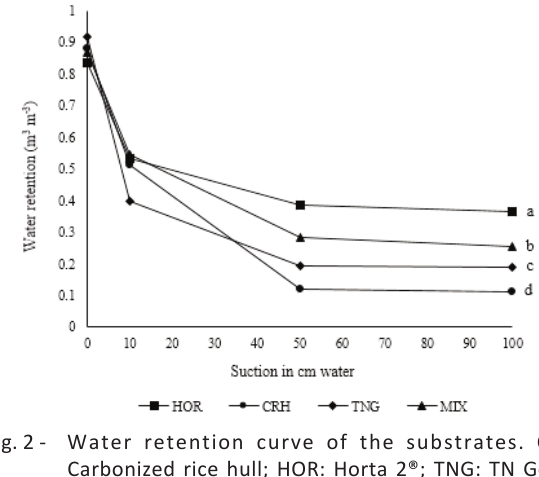
Fig. 2 - Water retention curve of the substrates. CRH: Carbonized rice hull; HOR: Horta 2®; TNG: TN Gold®; MIX: mixture. Different letters indicate significant diffe- rences by the Tukey test (P≤0.05, n = 3).